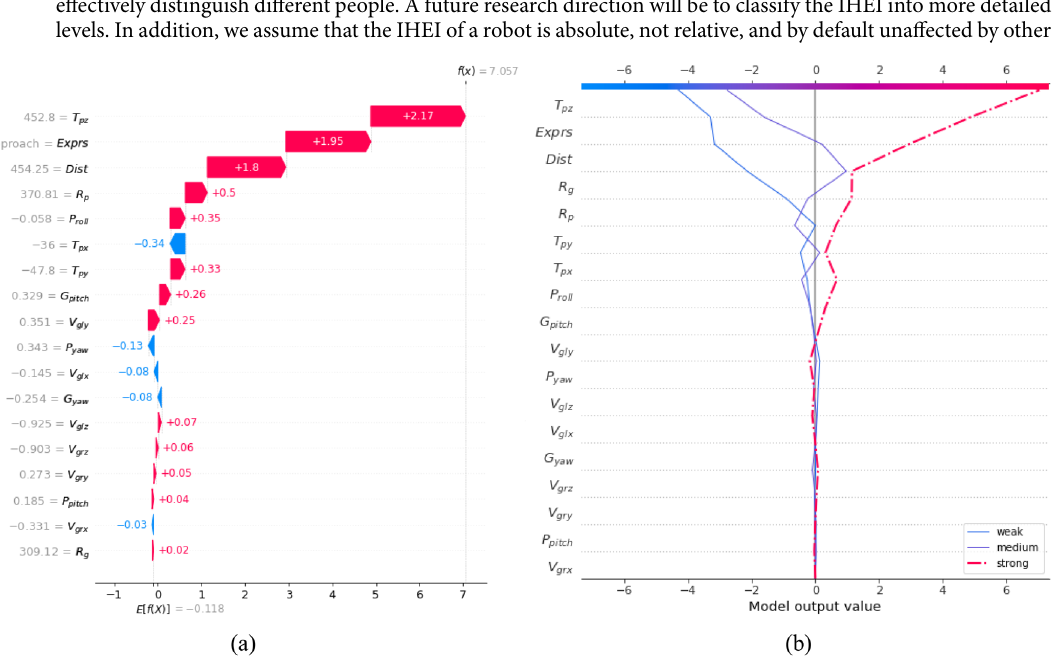
Figure 9. SHAP analysis of an example where the IHEI is predicted to be strong. ( a ) The degree to which each feature contributes to the predicted result of the interactive intention (corresponding value shown on the right side of each feature). Red indicates that the feature has a positive effect on the predicted result, whereas blue indicates that the feature has a negative effect. ( b ) The influence of each feature on the trend of different prediction results. Prediction results are presented based on the category of interactive intention that has the highest SHAP